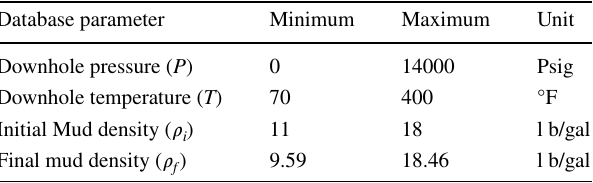
Table 4 Descriptive statistics of the input variables used in